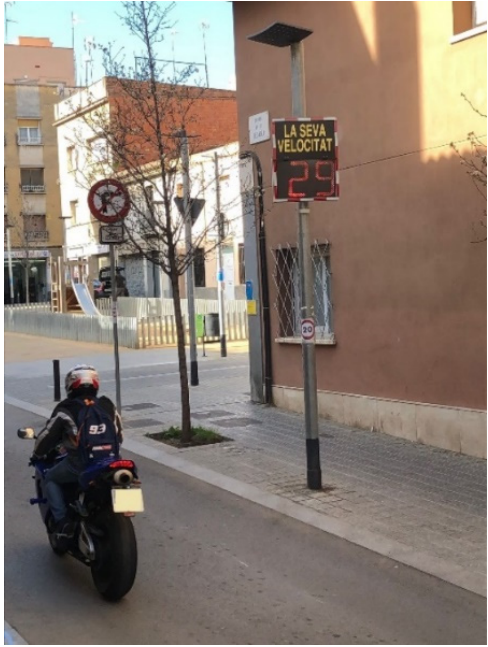
Figure 7. Informational radar on Segarra St. (photo by author), located at P2 (see Figure